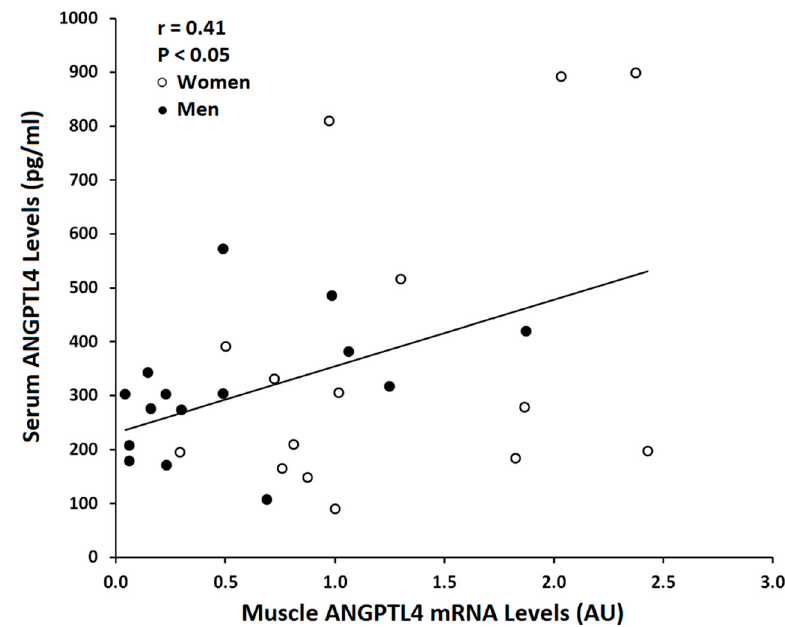
Figure 3. Relationship between muscle ANGPTL4 mRNA level and serum ANGPTL4 level (Total: n = 30, Women ○ : n = 15, Men ● : n = 15; r = 0.41, p < 0.05) before the intervention.